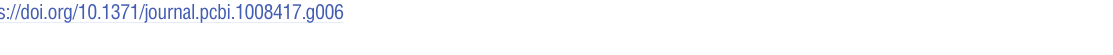
Fig 6. Inpatient C . difficile acquisition by specialty. The numbers at the bottom of each bar indicate the total number of CDI cases in each category.